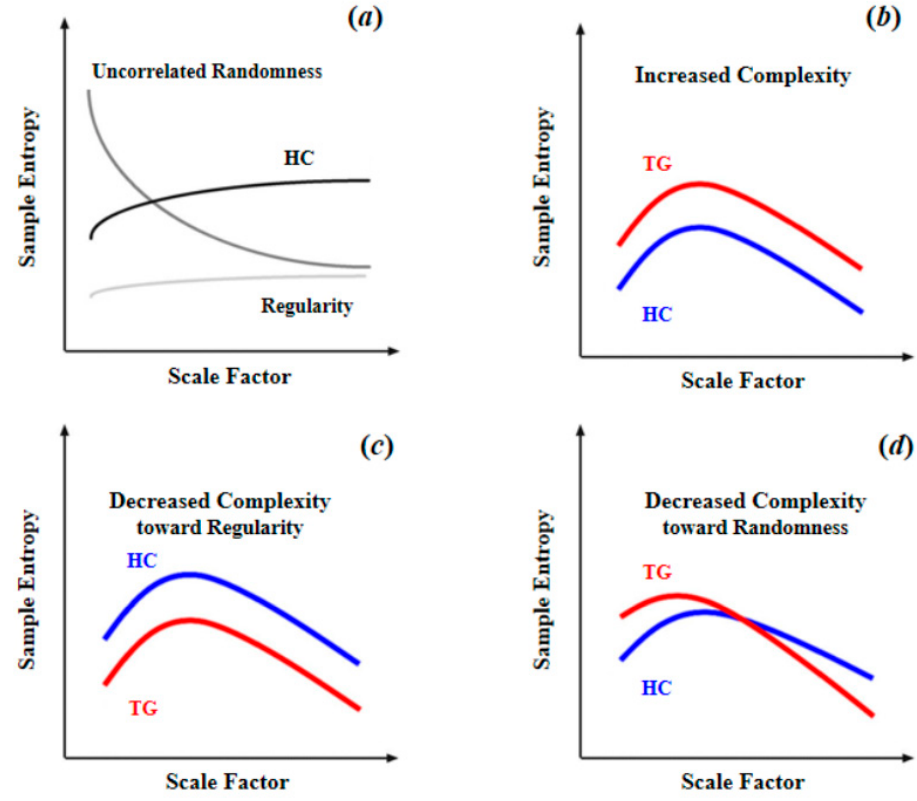
Figure 4. Schematic illustration of quantifying complexity of resting-state fMRI signal using multiscale entropy: ( a ) differences of MSE patterns across scale factors among the signals of uncorrelated randomness, HC, and regularity; ( b ) increased complexity as entropy increased in TG compared to HC across all scale factors; ( c ) decreased complexity toward regularity as reduced entropy in TG compared to HC across all scale factors; ( d ) decreased complexity toward randomness as entropy increased in fine time scale in TG compared to HC, and the entropy decayed as the scale factor increased. Reprinted with permission from ref. [11,26]. Copyright 2021